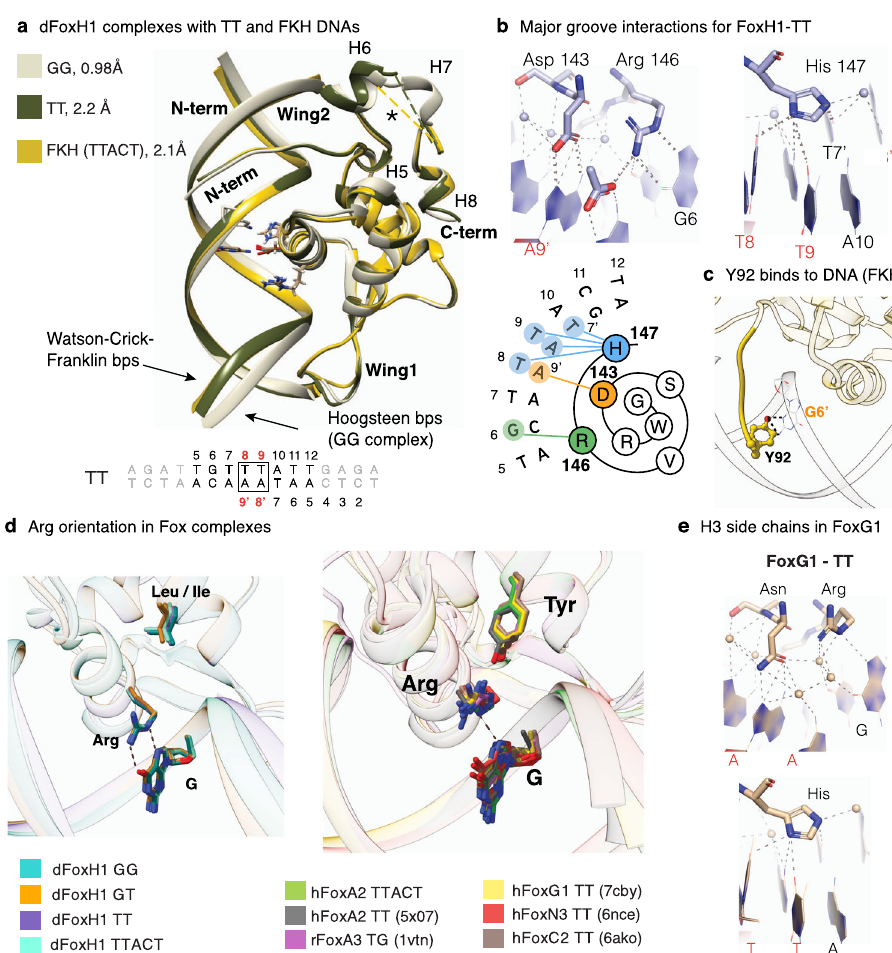
Fig. 5 | Binding to canonical forkhead motifs. a Superposition of the three zeb- ra fi shFoxH1-DNA complexeswith the GG(beige) and two TT sites (dark greenand gold). b Snapshotshighlightingdirectandwater-mediated polarcontactsfromthe Asp143, Arg146, and His147, located in H3, with nucleobases (distance up to 3.6Å) of the major groove for the FoxH1-TT complex, with a summary of the FoxH1 interactions with the TT site represented as a 2D Wenxiang diagram. c Tyr92 speci fi c interaction with the minor groove in the FHK DNA. d Different